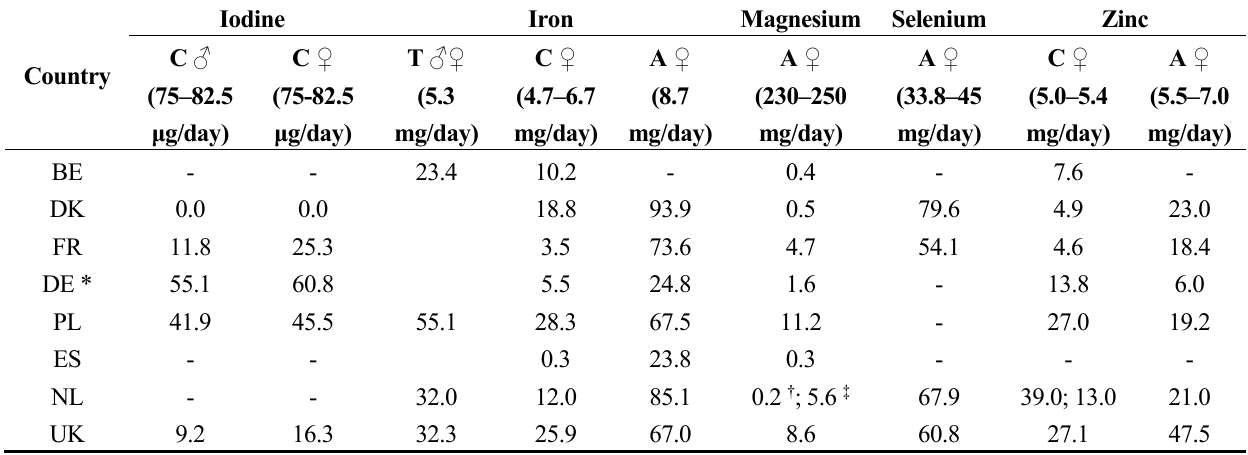
Table 2. Percent of children with intakes of select micronutrients intake estimated average requirement (EAR) as reported in various surveys in several European